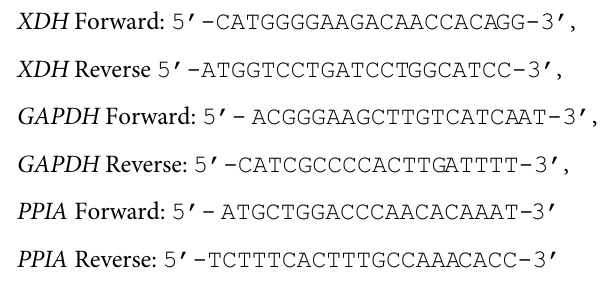
PPIA Reverse: 5’-TCTTTCACTTTGCCAAACACC-3’